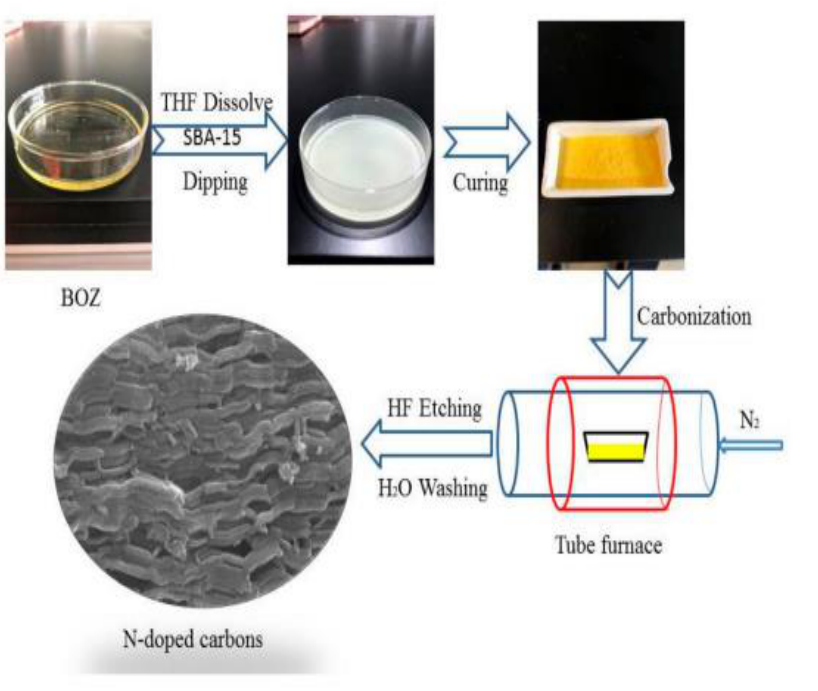
Figure 9. Preparation process of nitrogen-doped carbonized benzoxazine. (Reproduced from the work in [57] with permission.)